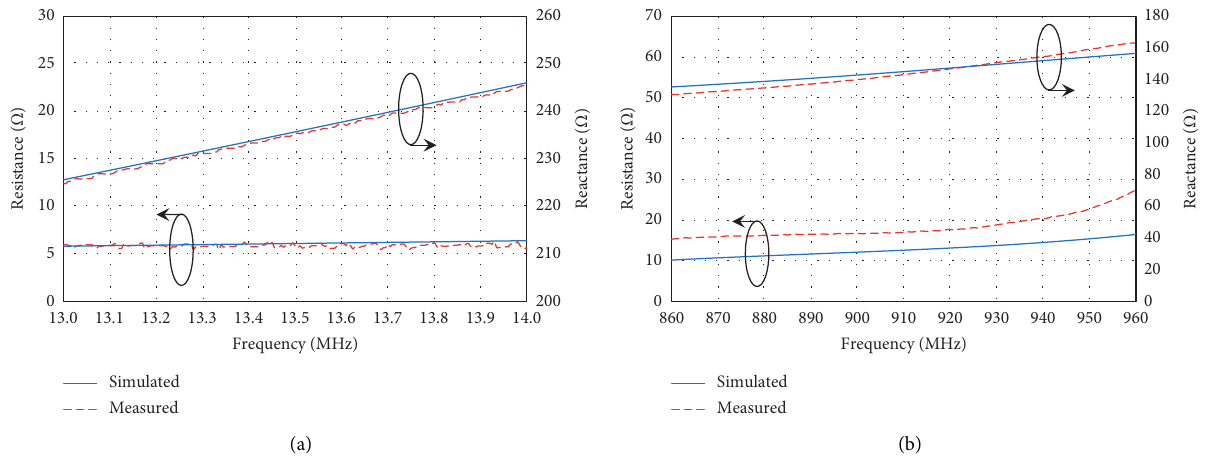
Figure 14: The simulated and measured impedance: (a) HF-RFID structure and (b) UHF-RFID